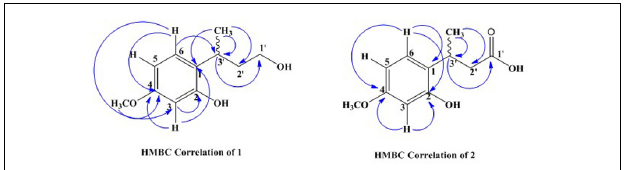
FIGURE 2 | Important HMBC correlation of compounds [ 1 and 2